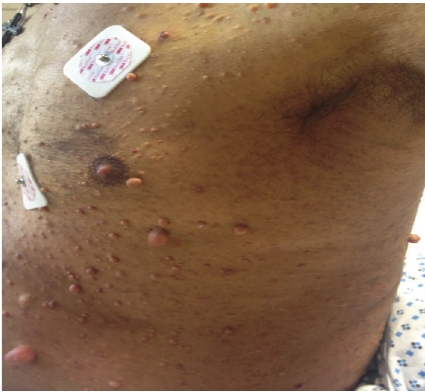
Figure 2: Subcutaneous neurofibromas and axillary freckling as noted in the patient at the time of